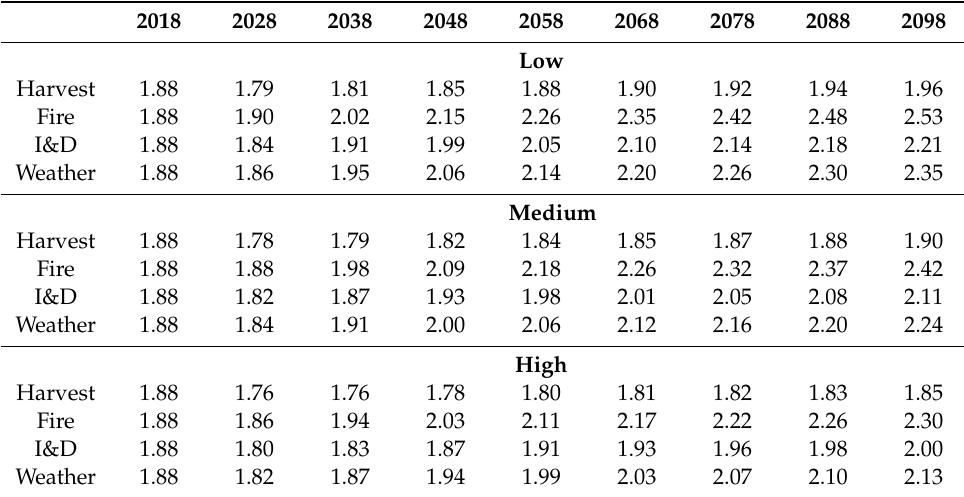
Table 5. Predicted total forest aboveground biomass (Pg C) from 2018 to 2098 under disturbances (harvest, fire, insect and disease, and weather) with low, medium, and high severity in the Northern US. I&D: insects and